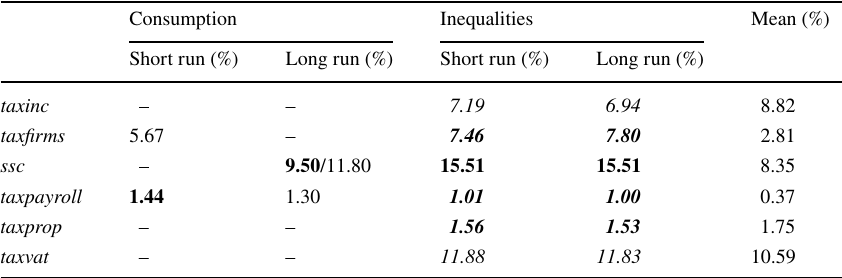
Table 6 Summary of tax items threshold values for households’ consumption and inequalities